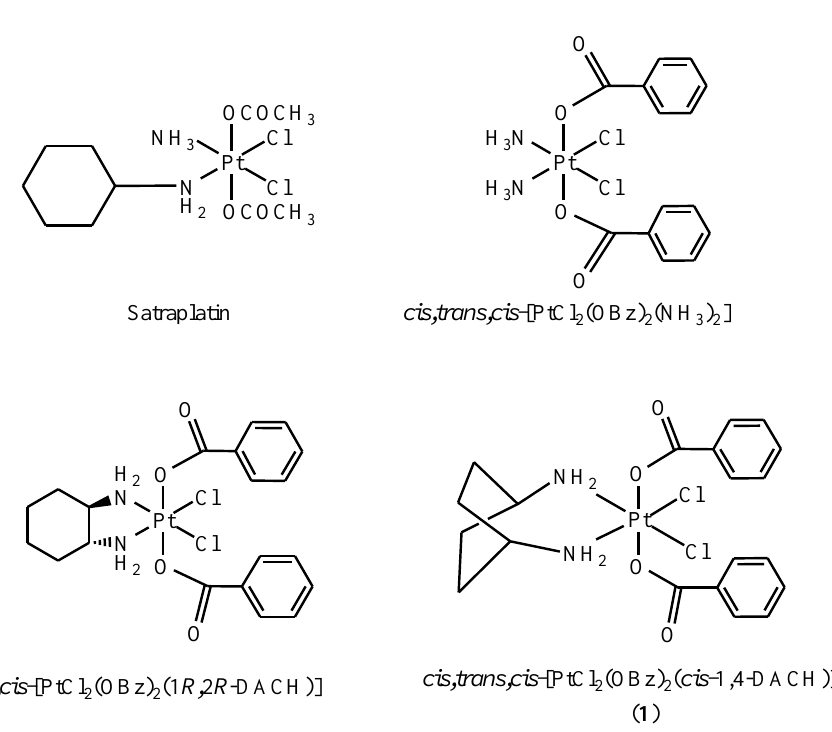
Figure 2. Sketches of Pt(IV) prodrugs (OBz, benzoate; DACH,